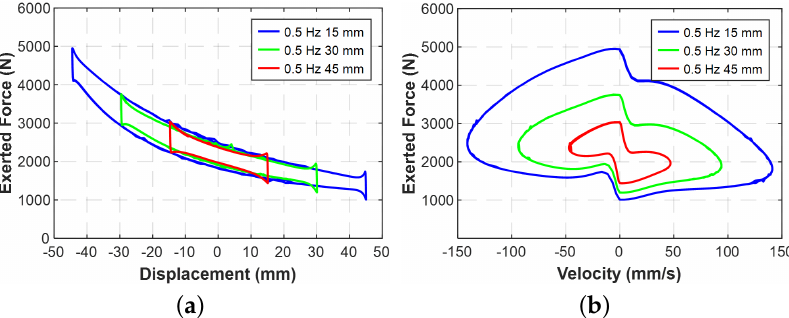
Figure 9. Exerted force ( a ) Force-displacement loop ( b ) Force-velocity